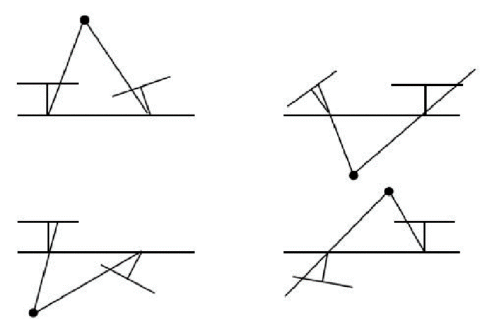
Figure 16. Relative poses of the keyframes corresponding to four sets of solutions.